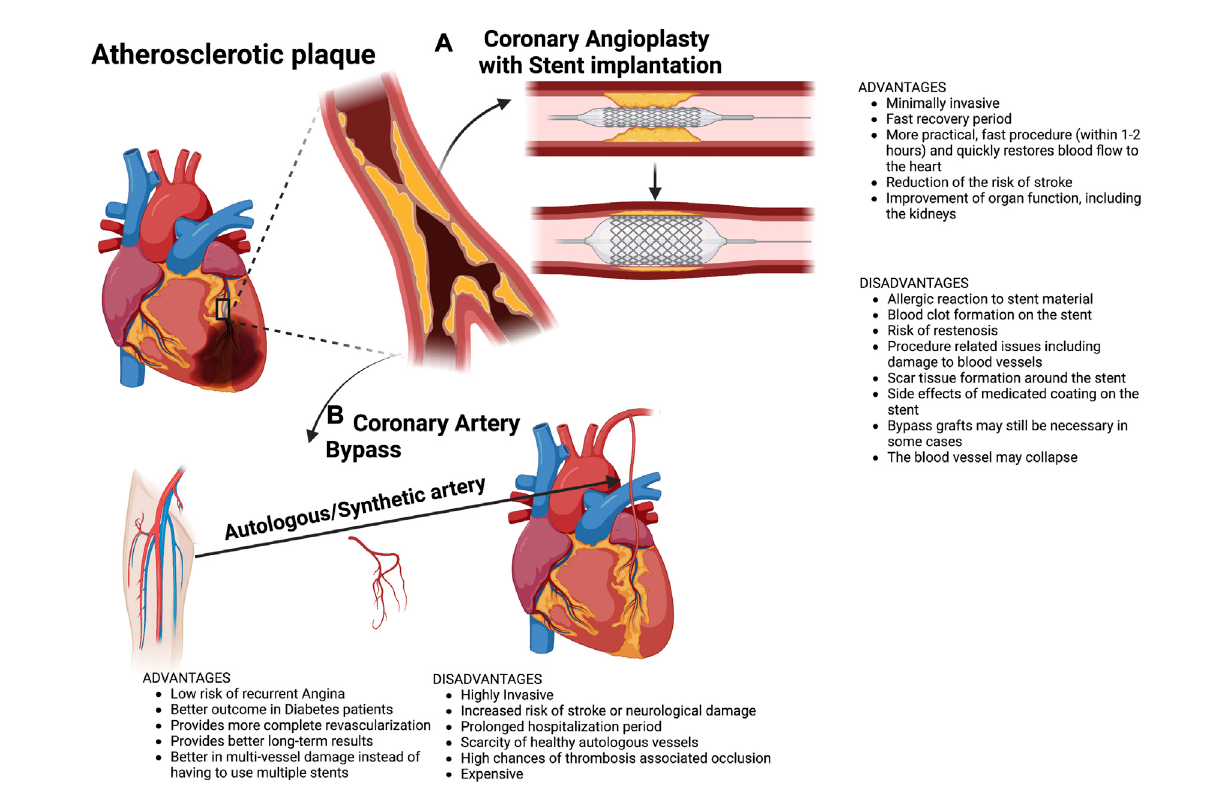
FIGURE 1 Common clinical procedures to treat coronary occlusion by atherosclerosis. (A) Coronary angioplasty with stent implantation and (B) Coronary artery bypass, either with an autologous artery or synthetic artery. Main advantages and disadvantages of both techniques are listed.